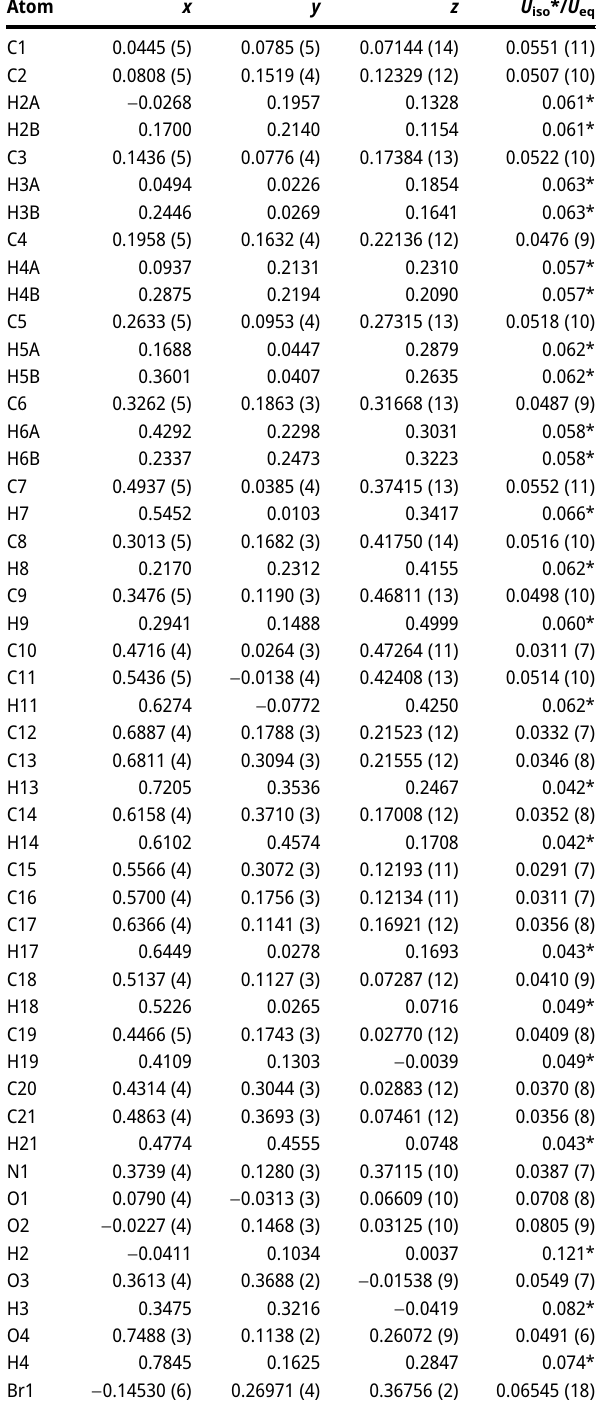
Table  : Fractional atomic coordinates and isotropic or equivalent isotropic displacement parameters (Å 